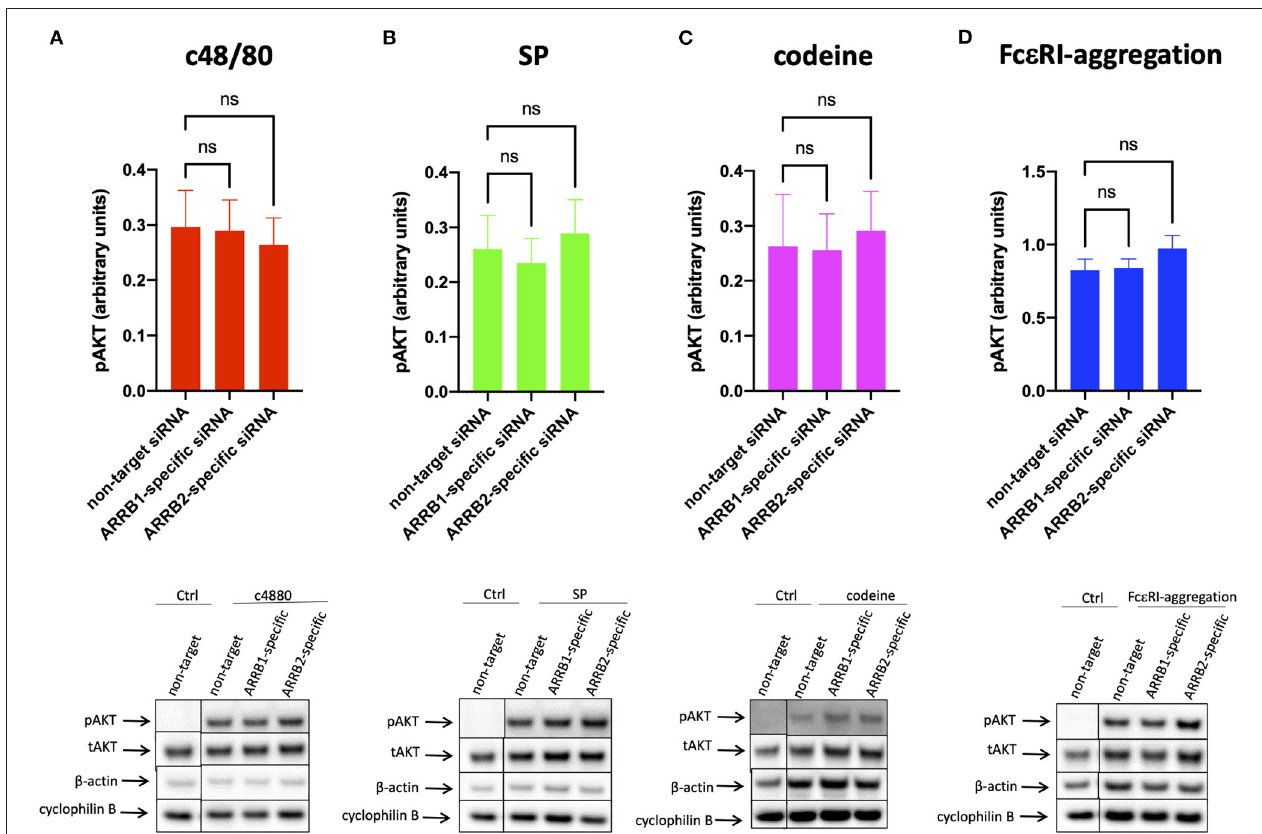
FIGURE 4 | AKT phosphorylation is unaffected by β -arrestin-1 or β -arrestin-2 knockdown. MCs were treated with ARRB1-selective, ARRB2-selective, or non-target siRNA for 48h and stimulated with (A) c48/80, (B) SP, (C) codeine for 1min, or (D) Fc ε RI aggregation for 30min exactly as indicated in Figure 3 . Phosphorylated (p) and total (t) AKT and loading controls ( β -actin and cyclophilin B) detected serially on the same membranes. (A–D) upper panel: relative pAKT normalized against tAKT expression; lower panel: representative blots showing pAKT and all loading controls. Mean ± SEM, n = 4–13 independent experiments, ns, not